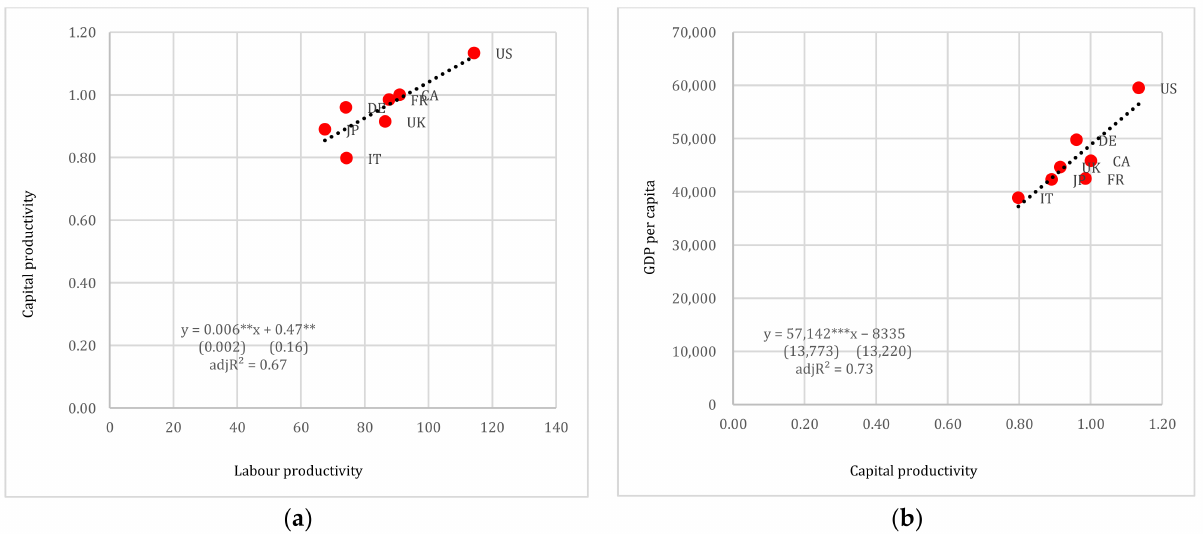
Figure 10. ( a ) Labour productivity vs. capital productivity and ( b ) capital productivity vs. GDP per capita (in USD pps), G7. Note: Standard errors reported in parentheses. **, *** denote 5% and 1% levels of statistical significance,